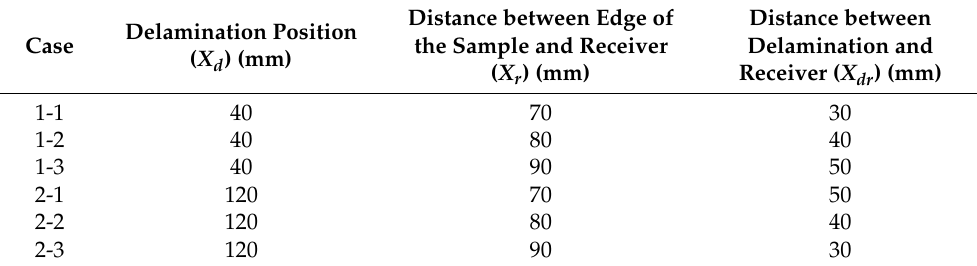
Table 1. Delamination position in the longitudinal direction.